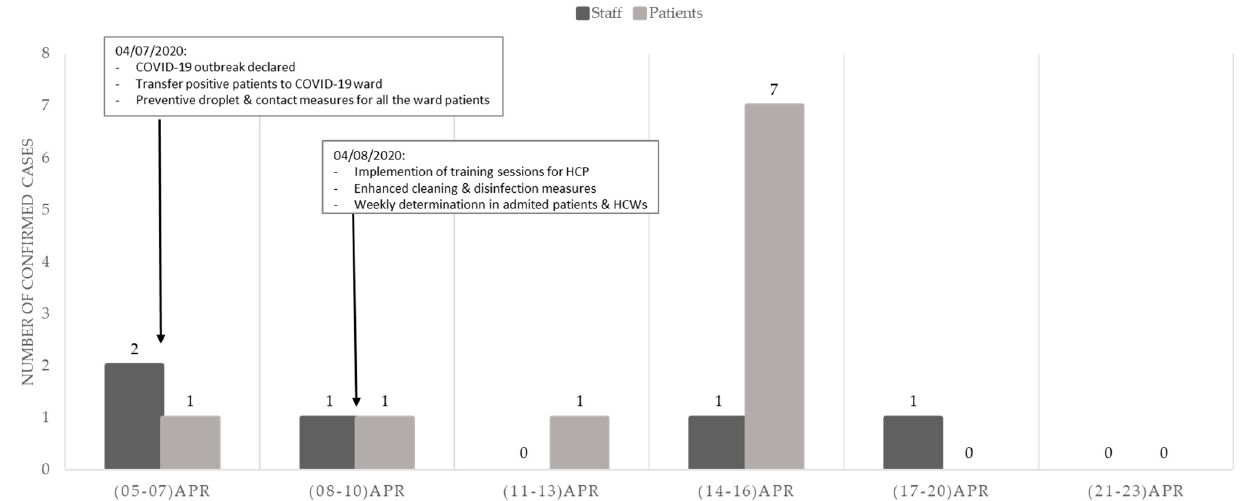
Figure 1. Epidemiological curve: COVID-19 coronavirus disease 2019; HCW healthcare workers; ICP infection control and prevention.